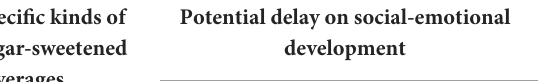
TABLE 3 Associations of four kinds of maternal sugar-sweetened beverages consumption on social-emotional development at child at 6 and 12